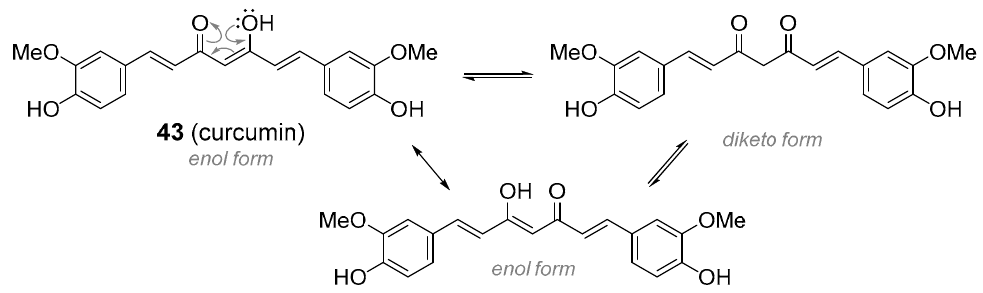
Figure 11. Curcumin exists as a tautomeric mixture of ketoenol- and diketo-form. The ketoenol structure (depicted) is more common in nature .